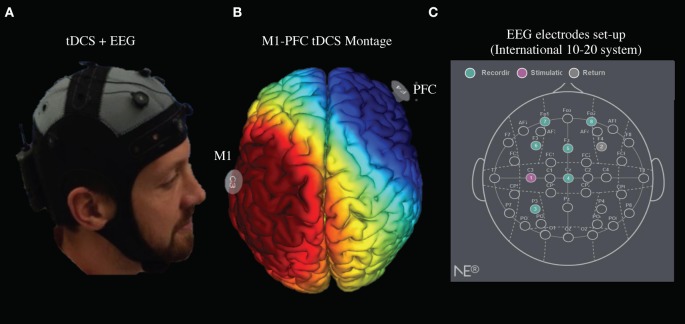
tDCS Stimulation and EEG recording setup. (A) M1-PFC tDCS set up with concurrent EEG. (B) Electric current pathway from M1 anode in red to PFC cathode in blue. (C) tDCS anode/cathode and EEG channel locations set up.